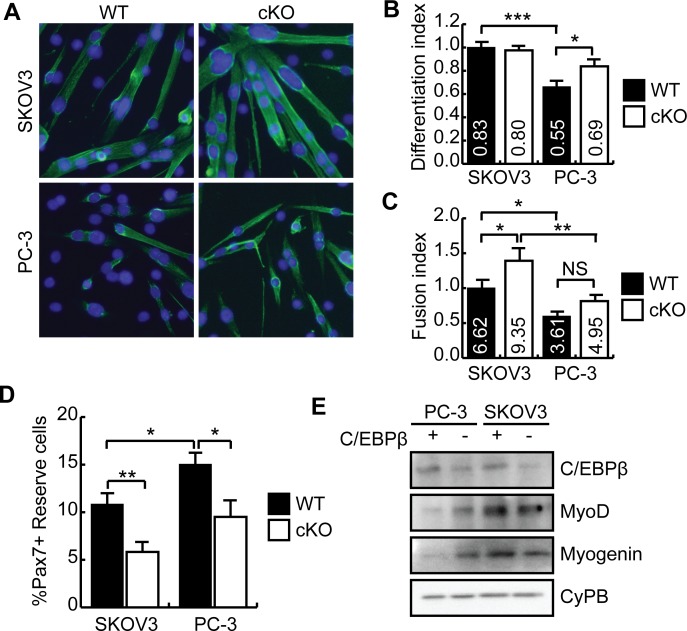
C/EBPβ null primary myoblasts are insensitive to conditioned medium from the PC-3 tumor.
(A) Indirect immunofluorescence of myosin heavy chain (MyHC) expression in primary myoblasts isolated from Cebpb
fl/fl
Pax7
+/+ (WT) and Cebpb
fl/fl
Pax7
CreER/+ (cKO) mice and cultured with SKOV3 or PC-3 conditioned media for 2 days, and induced to differentiate for an additional 2 days. (B) Differentiation index (#myonuclei/#nuclei) of primary myoblasts cultures in (A). *p<0.05, ***p<0.001, n = 6. (C) Fusion index (#myonuclei/myotube) for cells differentiated as in (A). *p<0.05, **p<0.01, n = 6. (D) Percentage of Pax7+ cells relative to total nuclei in cultures from (A) following differentiation, designated as reserve cells. *p<0.05, **p<0.01, n = 6. (E) Western blot analysis of C/EBPβ and myogenic marker expression in primary myoblasts treated as in (A). Cyclophilin B (CyPB) is a loading control.